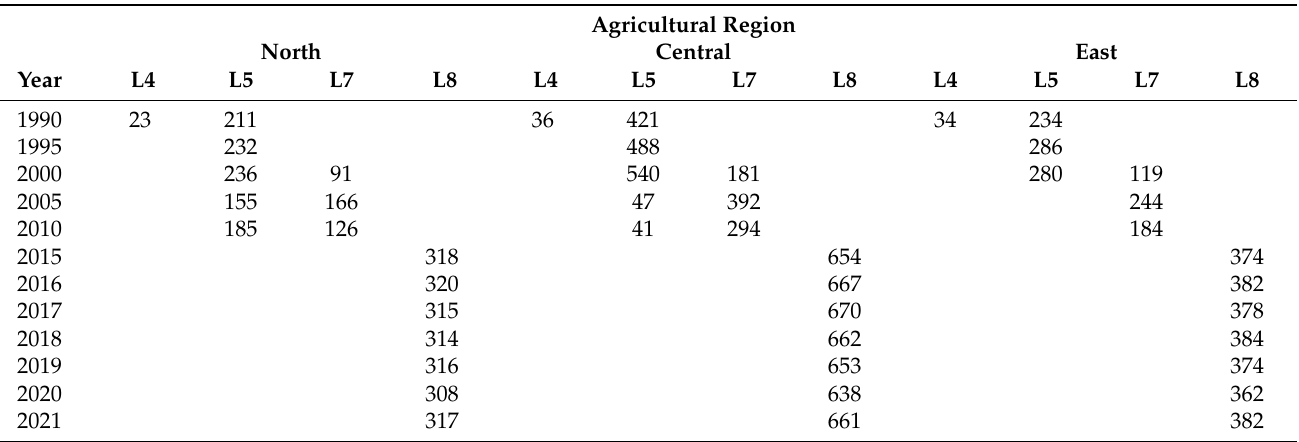
Table 1. The number of Landsat scenes utilized for each study year and region. L4/5/7/8 indicates Landsat 4/5/7/8, respectively.